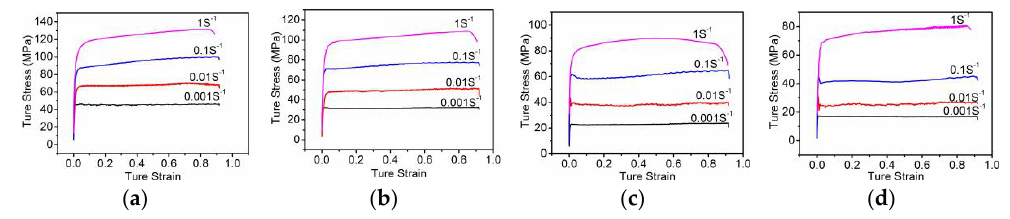
Figure 3. True stress-true strain curves of the specimens hot compressed at temperatures of 340 °C ( a ); 380 °C ( b ); 420 °C ( c ); and 460 °C; and ( d ) with different strain rates (0.001–1 s −1 ).